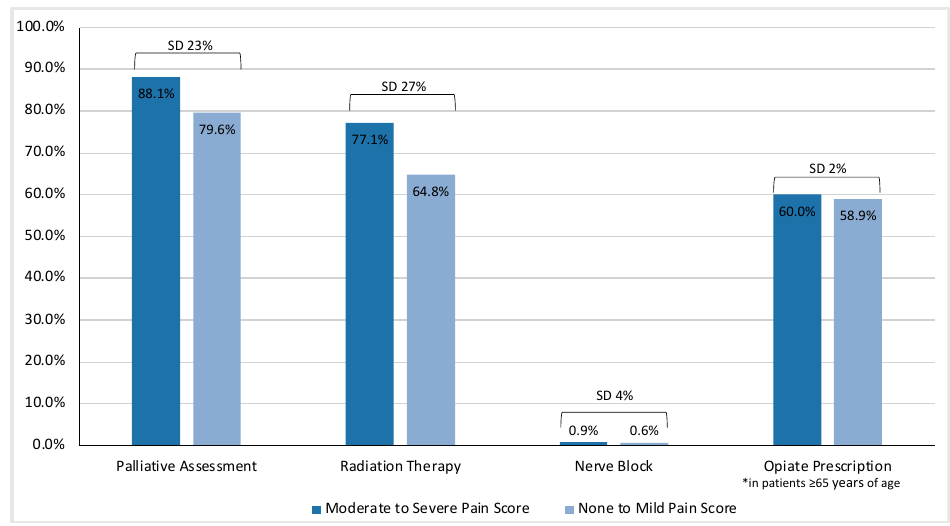
Figure 2. Intervention use strati fi ed by patient-reported pain score. Standardized di ff erence (SD).